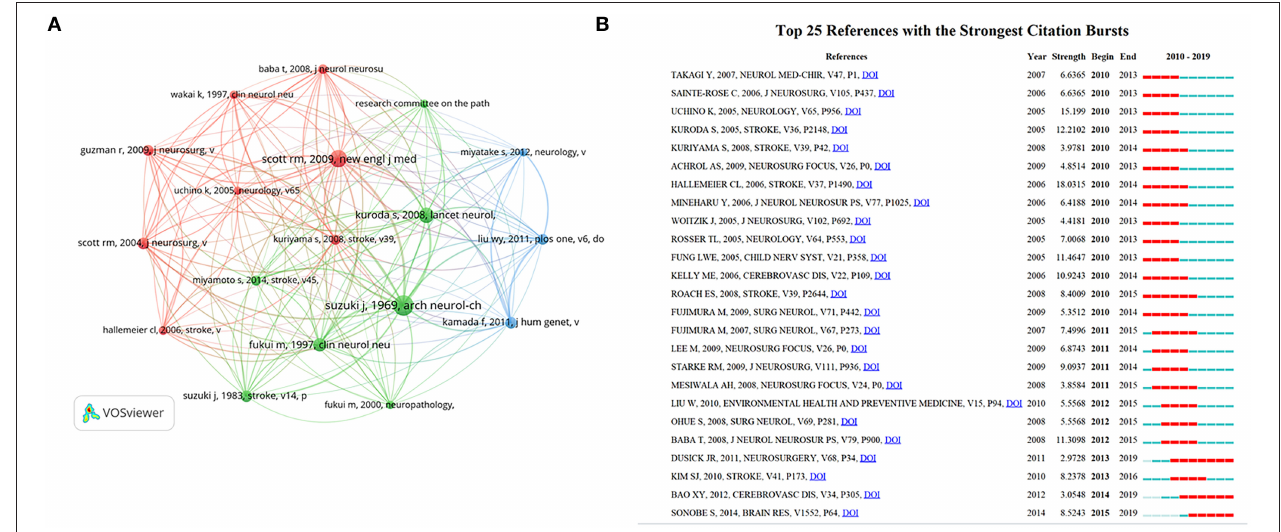
FIGURE 8 | (A) The Co-citation network visualization map of references on MMA research between 2010 and 2019. (B) The top 25 references with the strongest citation bursts on MMA research between 2010 and 2019. The red segment of the blue line denoted the burst duration of a keyword.